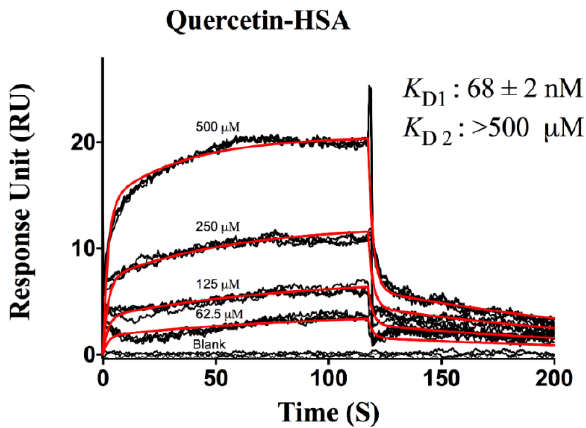
Figure 5. Sensorgram of quercetin interacting with HSA using the standard SPR injection method. The analytes were injected across the HSA surface in a two fold dilution series starting at 500 μ M. The orange lines show a global fit to the response data used to extract binding constants using a 1:2 kinetic analysis model. The binding constants are reported in the insets.